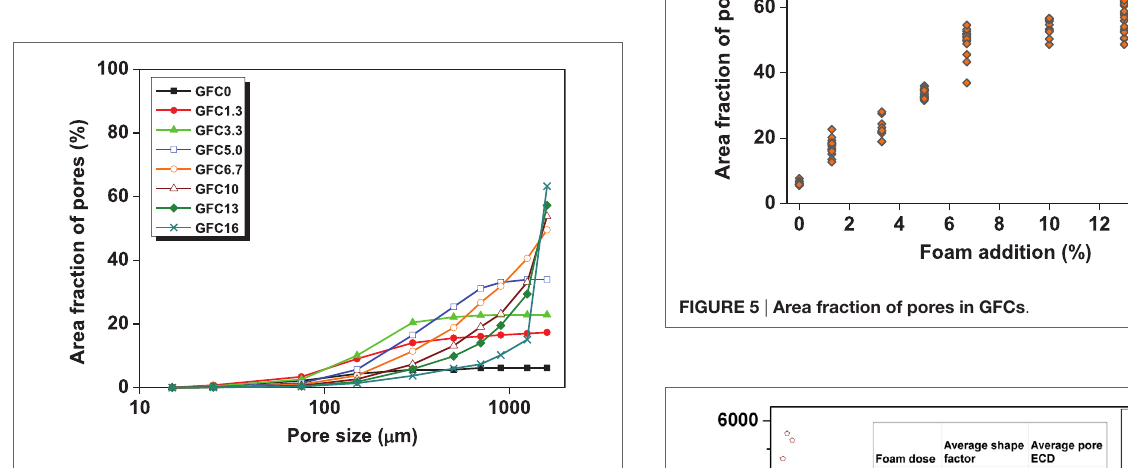
FigUre 4 | cumulative distribution of area fraction of pores in gFcs